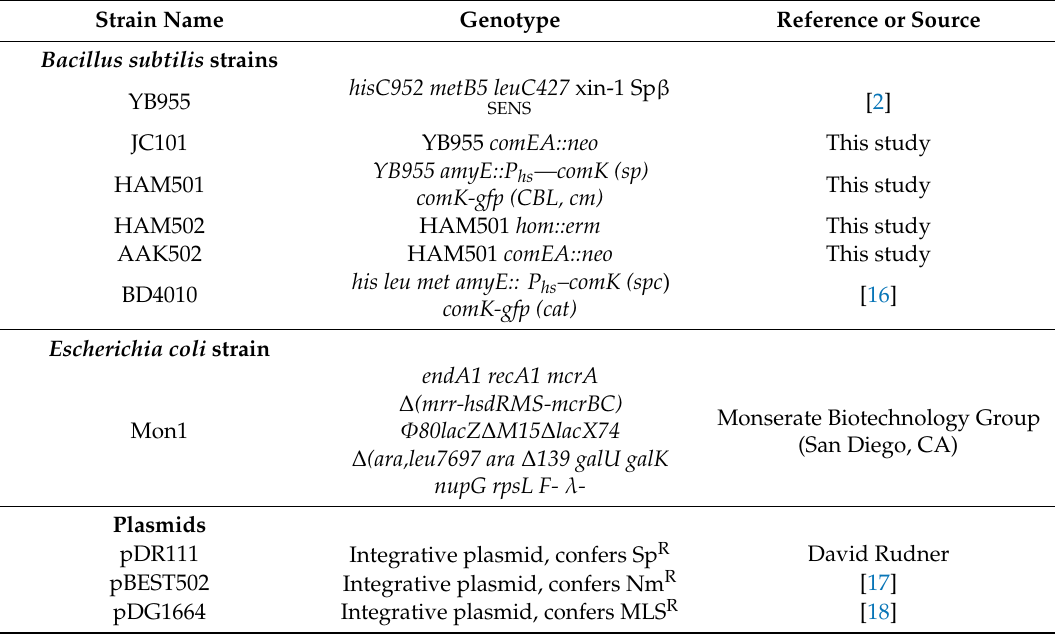
Table 1. Strains and plasmids used in this